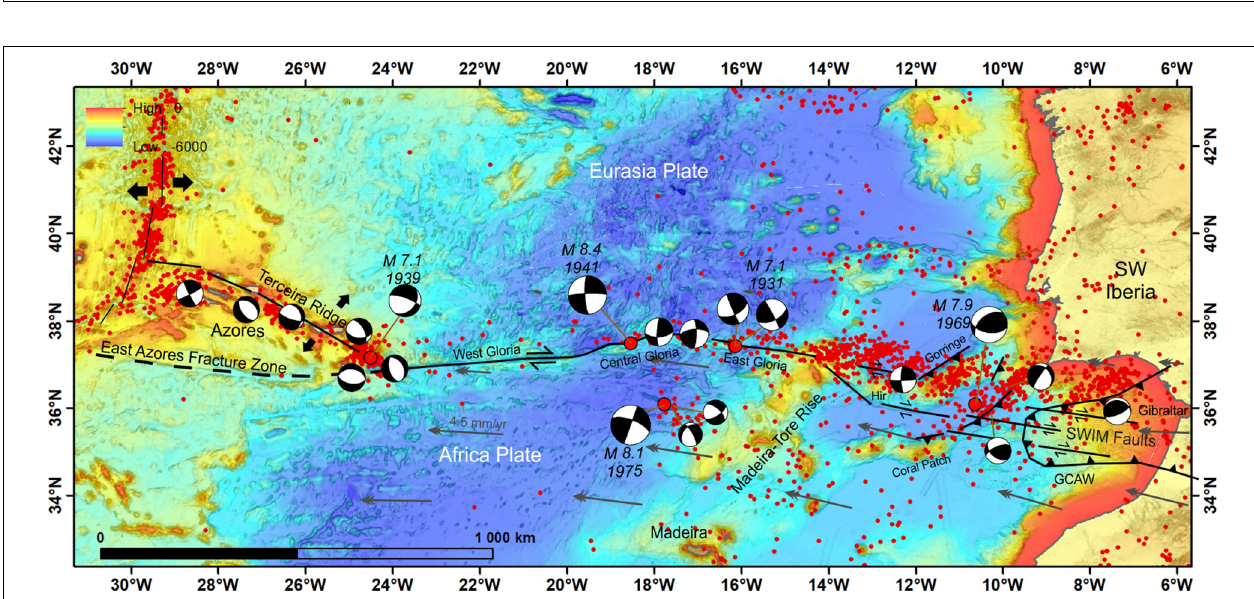
FIGURE 5 | Bathymetric map of the AGFZ region showing major structural units and seismic events. Hir, Hirondelle Seamount; GCAW, Gulf of Cadiz Accretionary Wedge; Red dots are epicenters of M > 4 earthquakes from the International Seismological Centre (ISC) for the period 1970–2017. Focal mechanisms from the database compiled by Custódio et al. (2016) ( M > 5.5). Gray arrows represent vectors from the relative Africa-Eurasia velocity field as modeled by the neotectonic model of Neres et al. (2016).